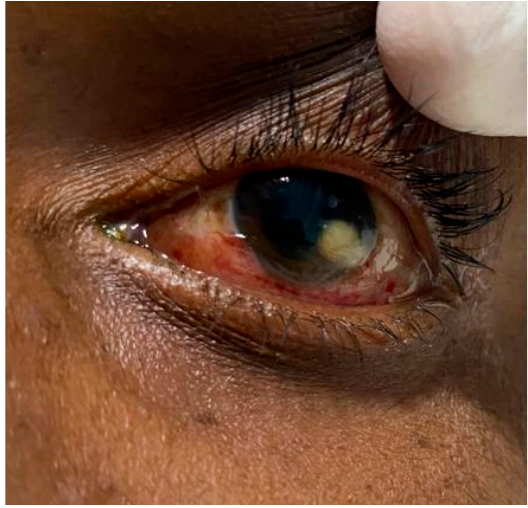
Figure 2. A hypopyon caused by septic embolization in the left eye that was suggestive of uveitis. Bedside ultrasound demonstrated a >50% collapsible inferior vena cava on the longi- tudinal axis and an oscillating vegetation 30 × 18 mm in the left atrium. Several boluses of intravenous crystalloid had no impact on the low blood pressure, and noradrenalin was started for inotropic cardiac functioning and peripheral vasoconstriction. The finding of a large vegetation was suggestive of IE, and blood was collected by venipuncture from three different sites prior to the administration of targeted empiric antibiotic. Vancomycin was administered up to 1 g/day to maintain the vancomycin trough levels at 20 µ g/mL. Further management included transthoracic echocardiography (Figure 3) and hematological and biochemical investigations, as shown in Table 1.